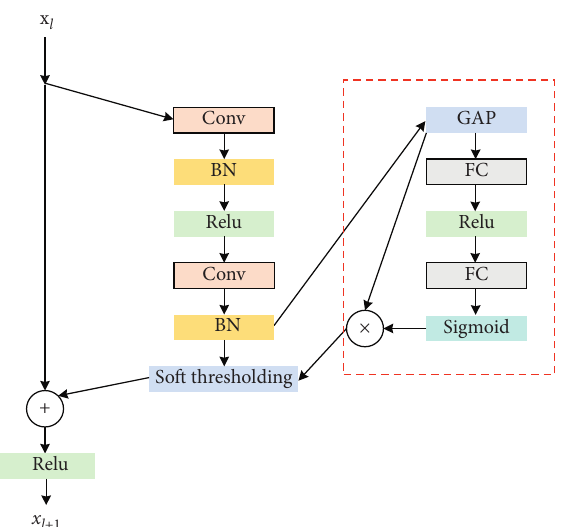
Figure 3: Deep residual shrinkage